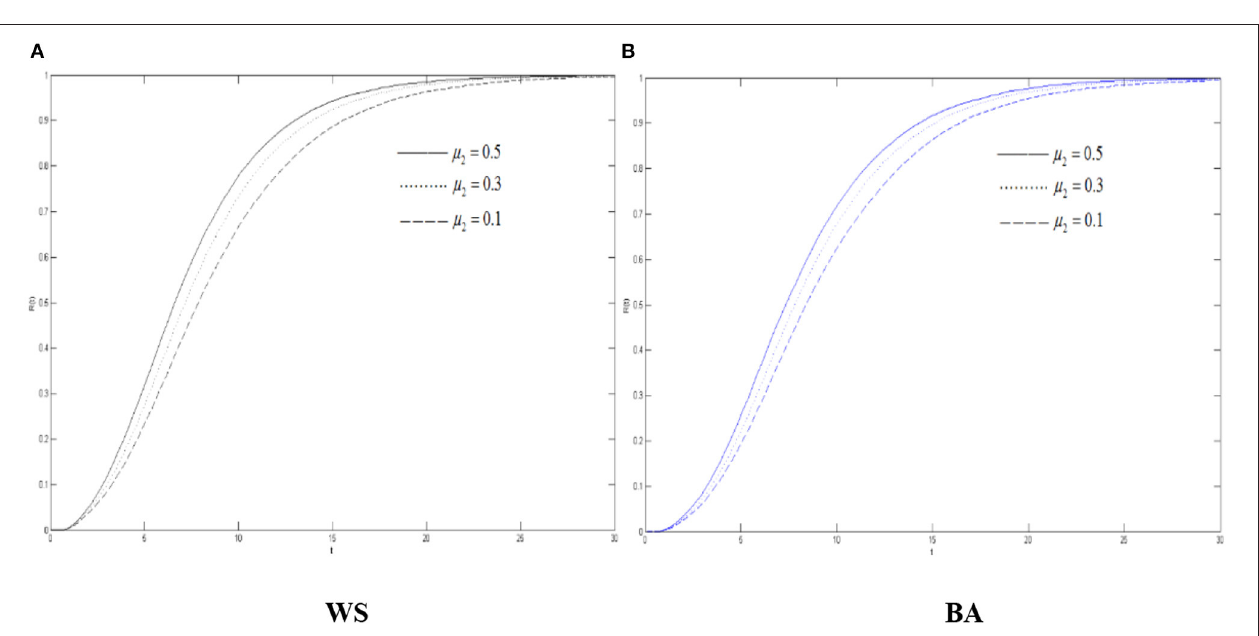
FIGURE 5 | The differences of role density in WS small world and BA scale-free network when µ 2 changes. (A) WS, (B) BA.